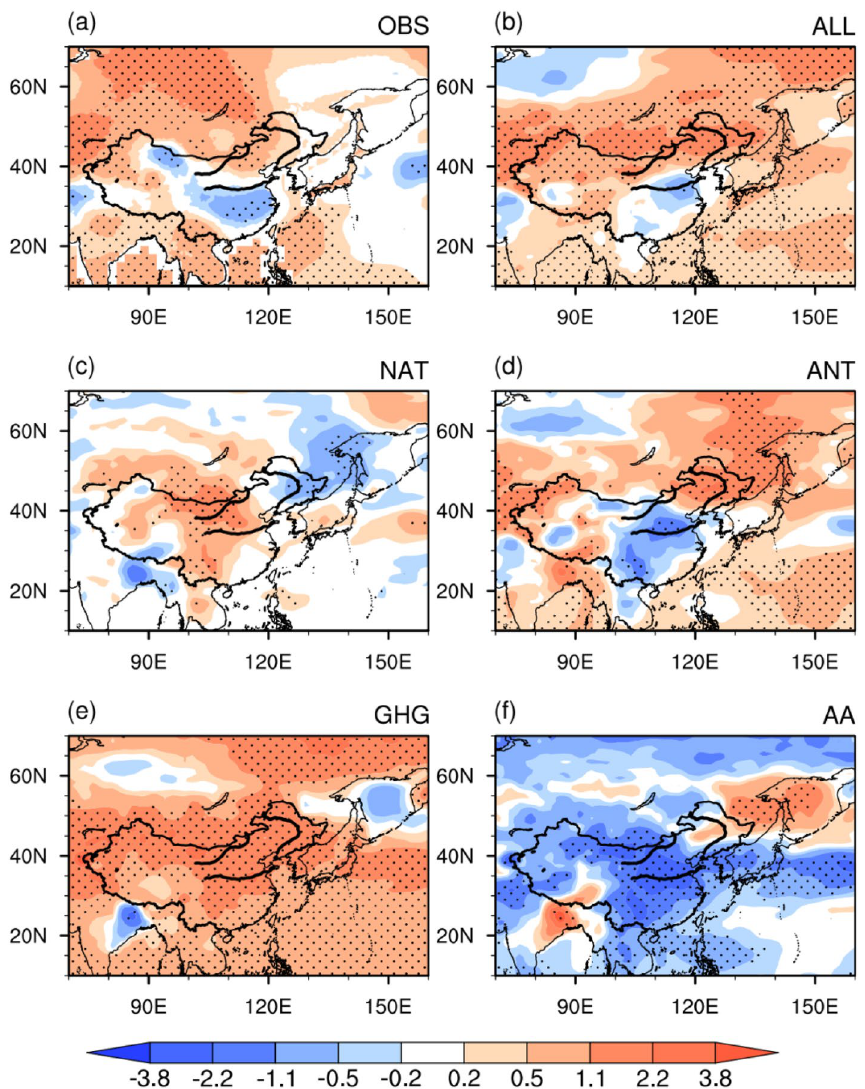
Figure 5. Linear trends of surface temperature (unit: °C month −1 55 yr −1 ). The linear trend of surface air temperature (sea surface temperature) in ( a ) is derived from CRU TS version 4.01 21 (URL: http://cruda ta.uea. ac.uk/cru/data/hrg/cru_ts_4.01/) (ERSST v3b 24 (URL: https ://psl.noaa.gov/data/gridd ed/data.noaa.ersst .v3. html)). The multimodel ensemble simulations of ( b ) historical run, ( c ) natural forcing run, ( d ) anthropogenic forcing run, ( e ) GHG forcing run, and ( f ) aerosol forcing run. Regions covered with dots feature linear trends significant at the 90% confidence level. This Figure is created by the NCAR Command Language (version 6.4.0 & URL: http://www.ncl.ucar.edu/Downl oad) 27